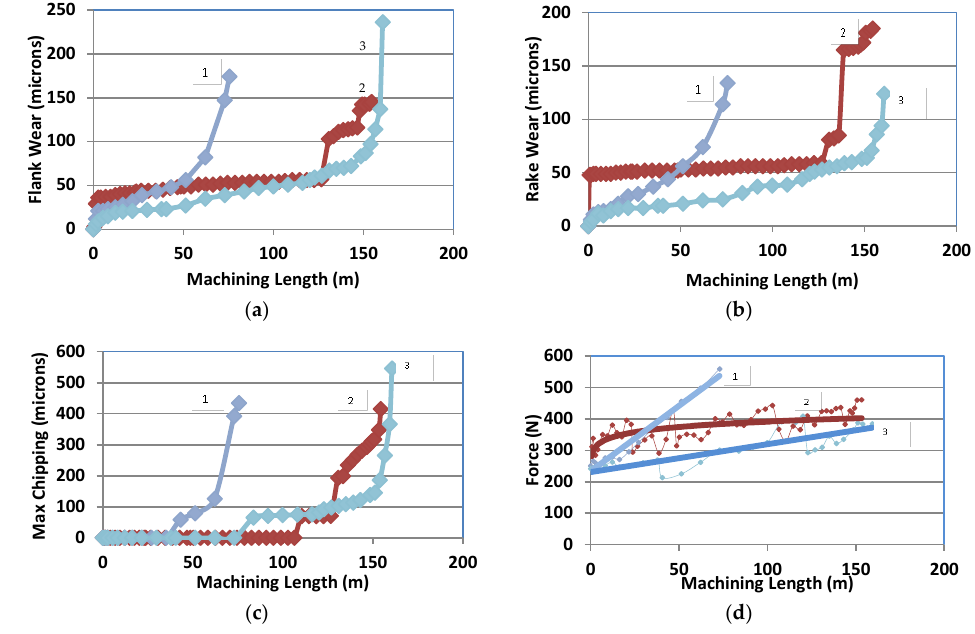
Figure 9. Tool-life data of the studied coatings vs. length of cut (m): ( a ) flank wear; ( b ) rake wear; ( c ) chipping intensity; ( d ) average cutting forces. 1: TiCrAlSiYN monolayer, 3 µ m; 2: TiCrAlN/TiCrAlSiYN bi-multilayer, 2 µ m; 3: TiCrAlN/ TiCrAlSiYN bi-multilayer, 3 µ m.